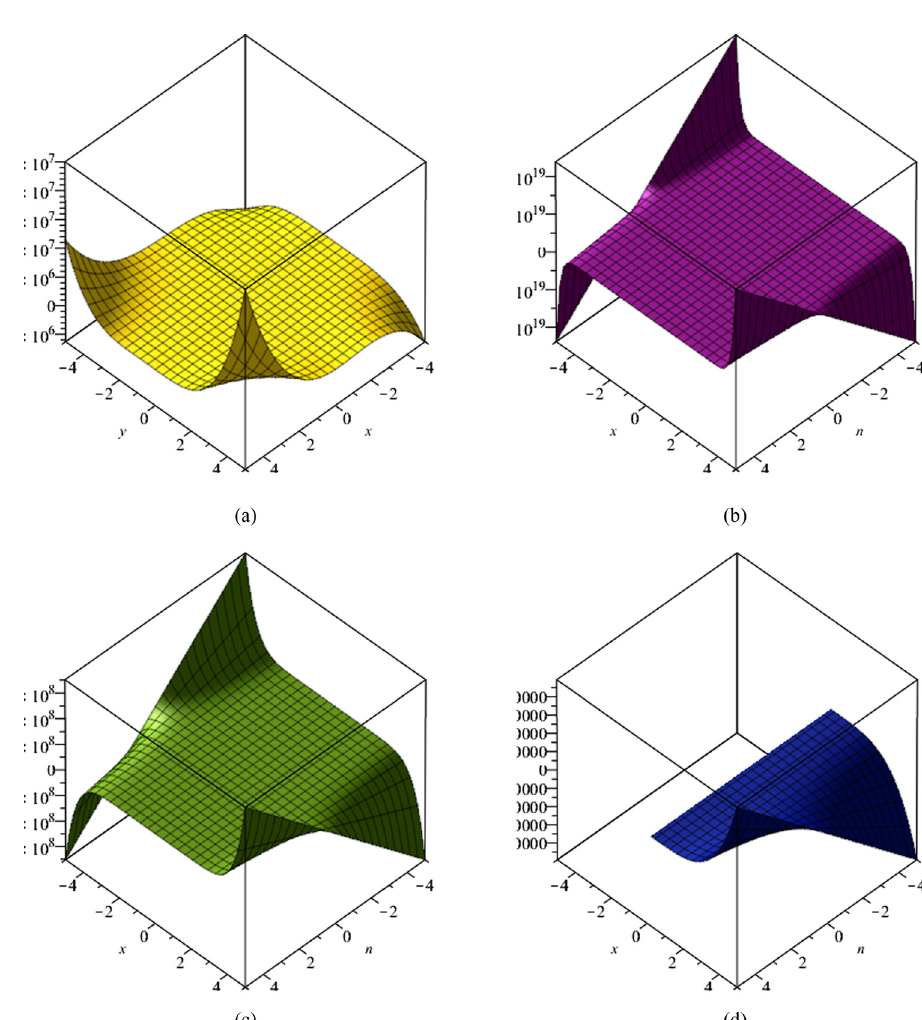
Figure 5: ( a ) M - polynomial, ( b ) F - polynomial, ( c ) S - polynomial, and ( d ) SO - polynomial of transition cuboctahedral bimetallic net - works ( MOPs )